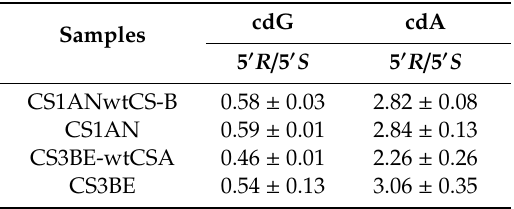
Table 1. Total amount of 5 (cid:48) R / 5 (cid:48) S ratio of cPu lesions in DNA isolated from CS1AN-wtCSB and CS1AN cells and CS3BE-wtCSA and CS3BE cells. Samples